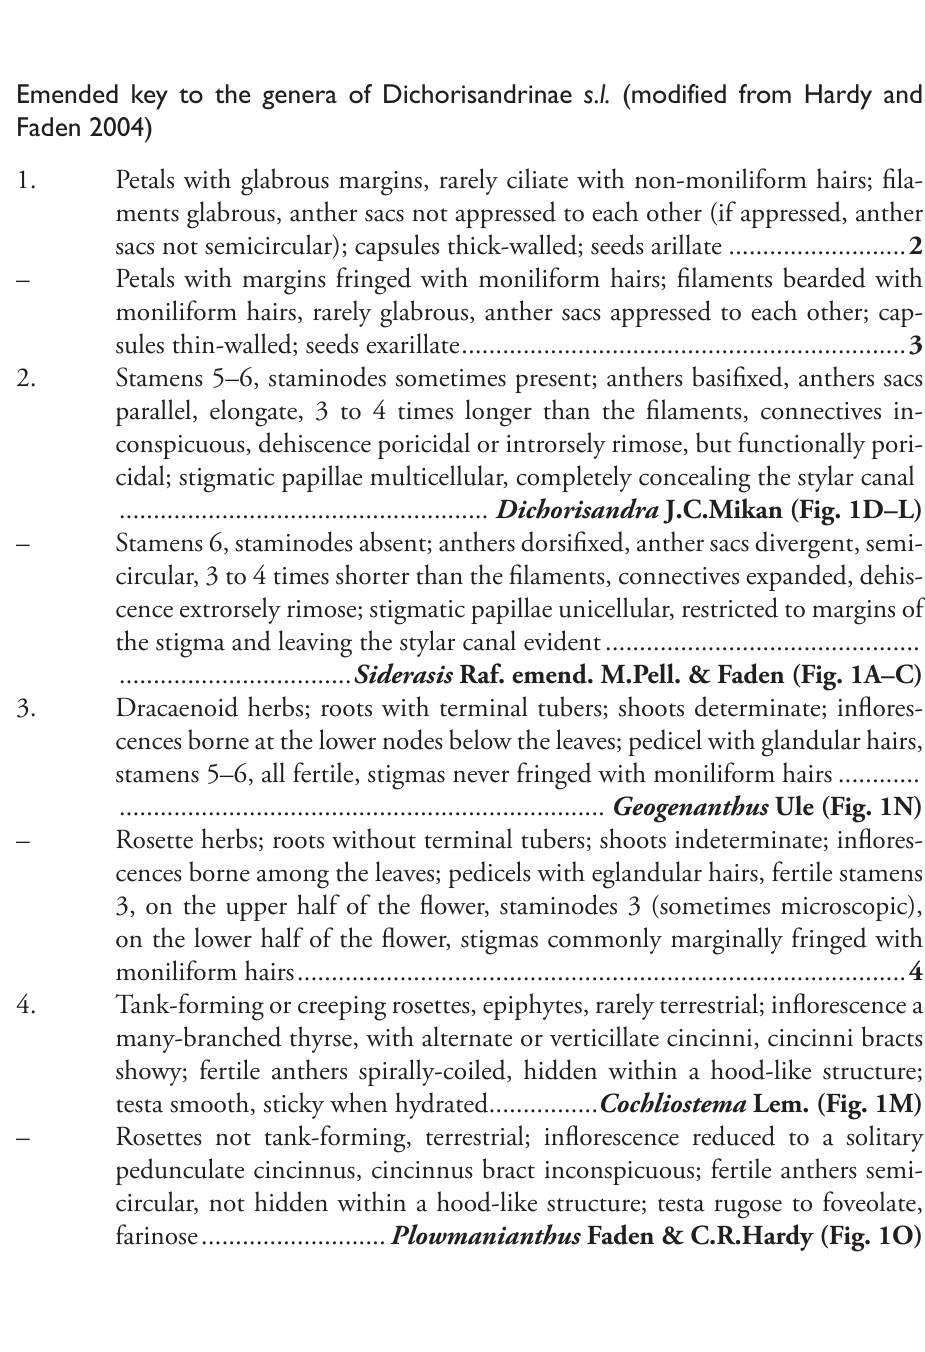
pedunculate cincinnus, cincinnus bract inconspicuous; fertile anthers semi- circular, not hidden within a hood-like structure; testa rugose to